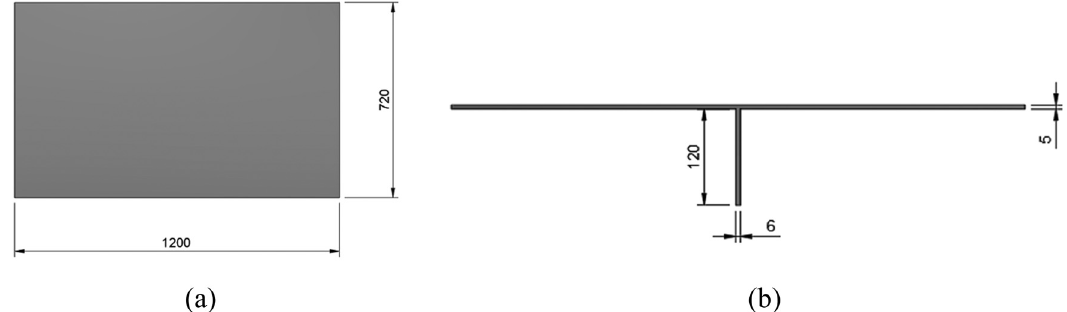
Figure 1: Illustration of a 2D thin - walled plate cross - section: ( a ) top - view plate cross - section and ( b ) side - view plate cross - section.